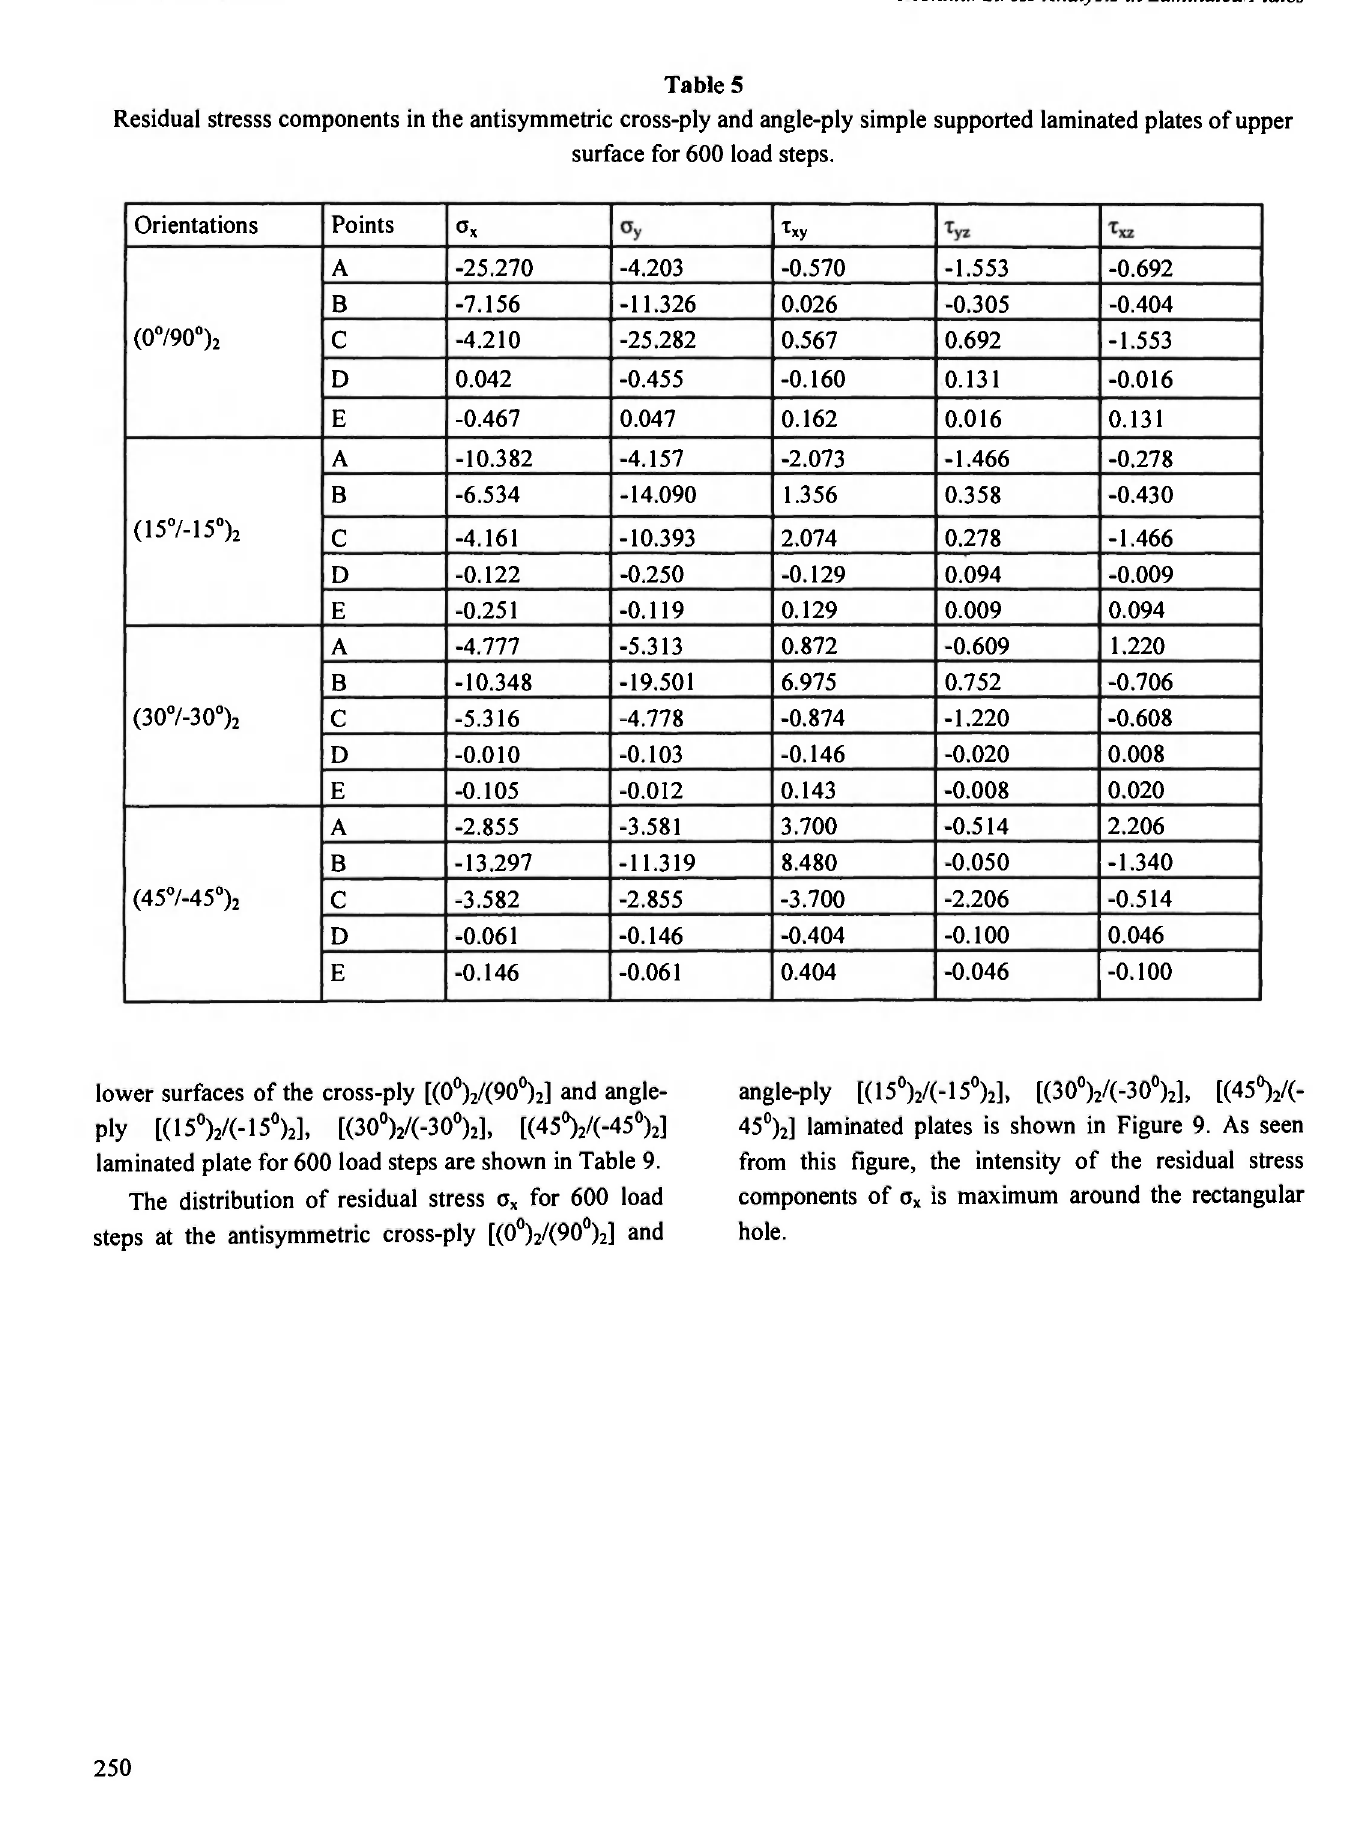
Residual stresss components in the antisymmetric cross-ply and angle-ply simple supported laminated plates of upper surface for 600 load